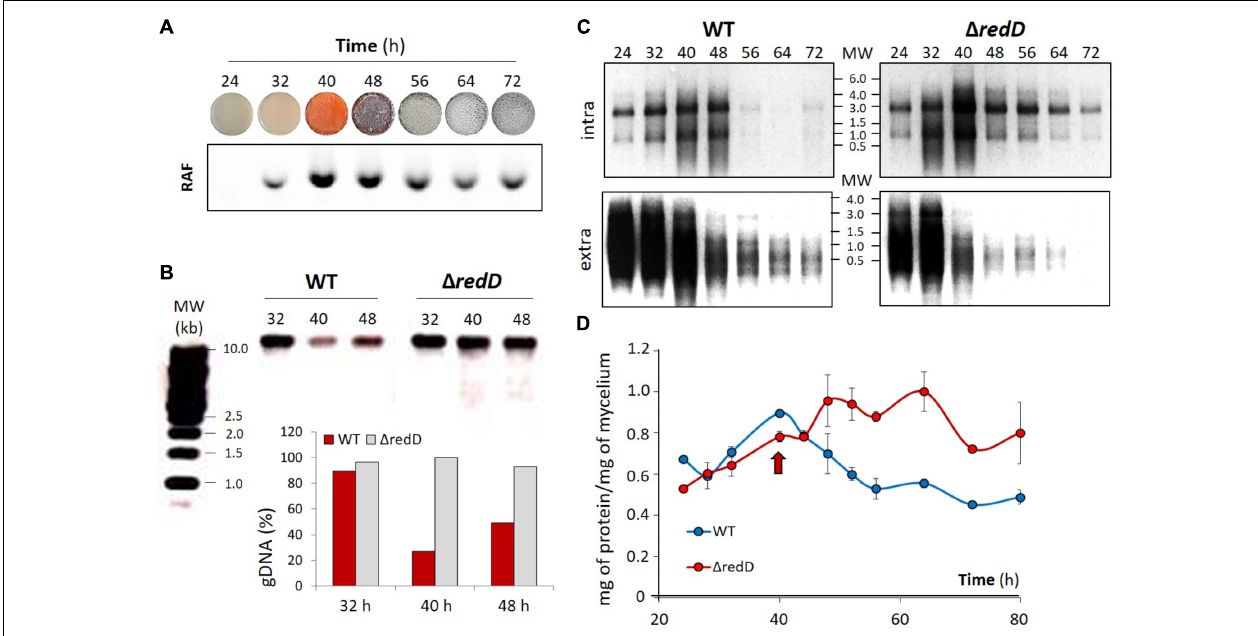
FIGURE 6 | Effect of the deletion of redD on DNA, RNA, and protein synthesis. (A) PdG production throughout the life cycle of S. coelicolor . RAF from mycelium extracts of S. coelicolor grown on the R2YE medium covered with cellophane disks. Extracts were deposited in an agarose gel and RAF was monitored after migration as described previously (56). (B) Ethidium bromide stained agarose gels and quantification showing the amount of genomic DNA extracted from 50 mg of mycelium of S. coelicolor M145 (WT) and its redD null mutant ( (cid:49) redD ). 100% refers to the maximum of genomic DNA collected, i.e., in the redD mutant at 40 h. (C) Ethidium bromide stained agarose gels showing intracellular (top panels) and extracellular (bottom panels) RNA extracted from S. coelicolor M145 (WT) and its redD null mutant ( (cid:49) redD ). (D) Quantification of the total protein content in crude extracts of mycelia of S. coelicolor WT (M145) and its redD null mutant. The red arrow indicates the timing of maximal PdGs